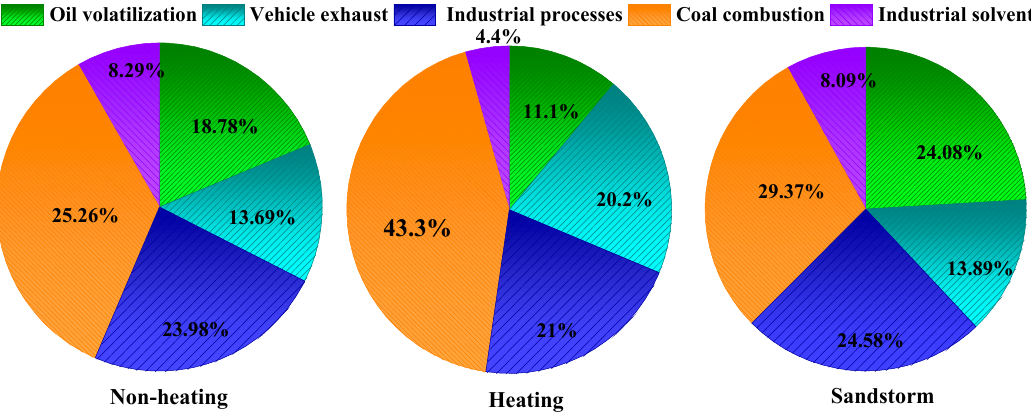
Figure 6. Source contributions to atmospheric VOCs during sampling periods in Dushanzi.